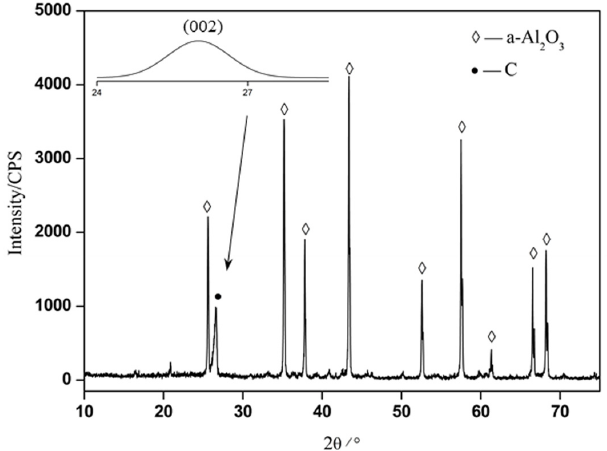
Figure 4. XRD pattern of the composites.